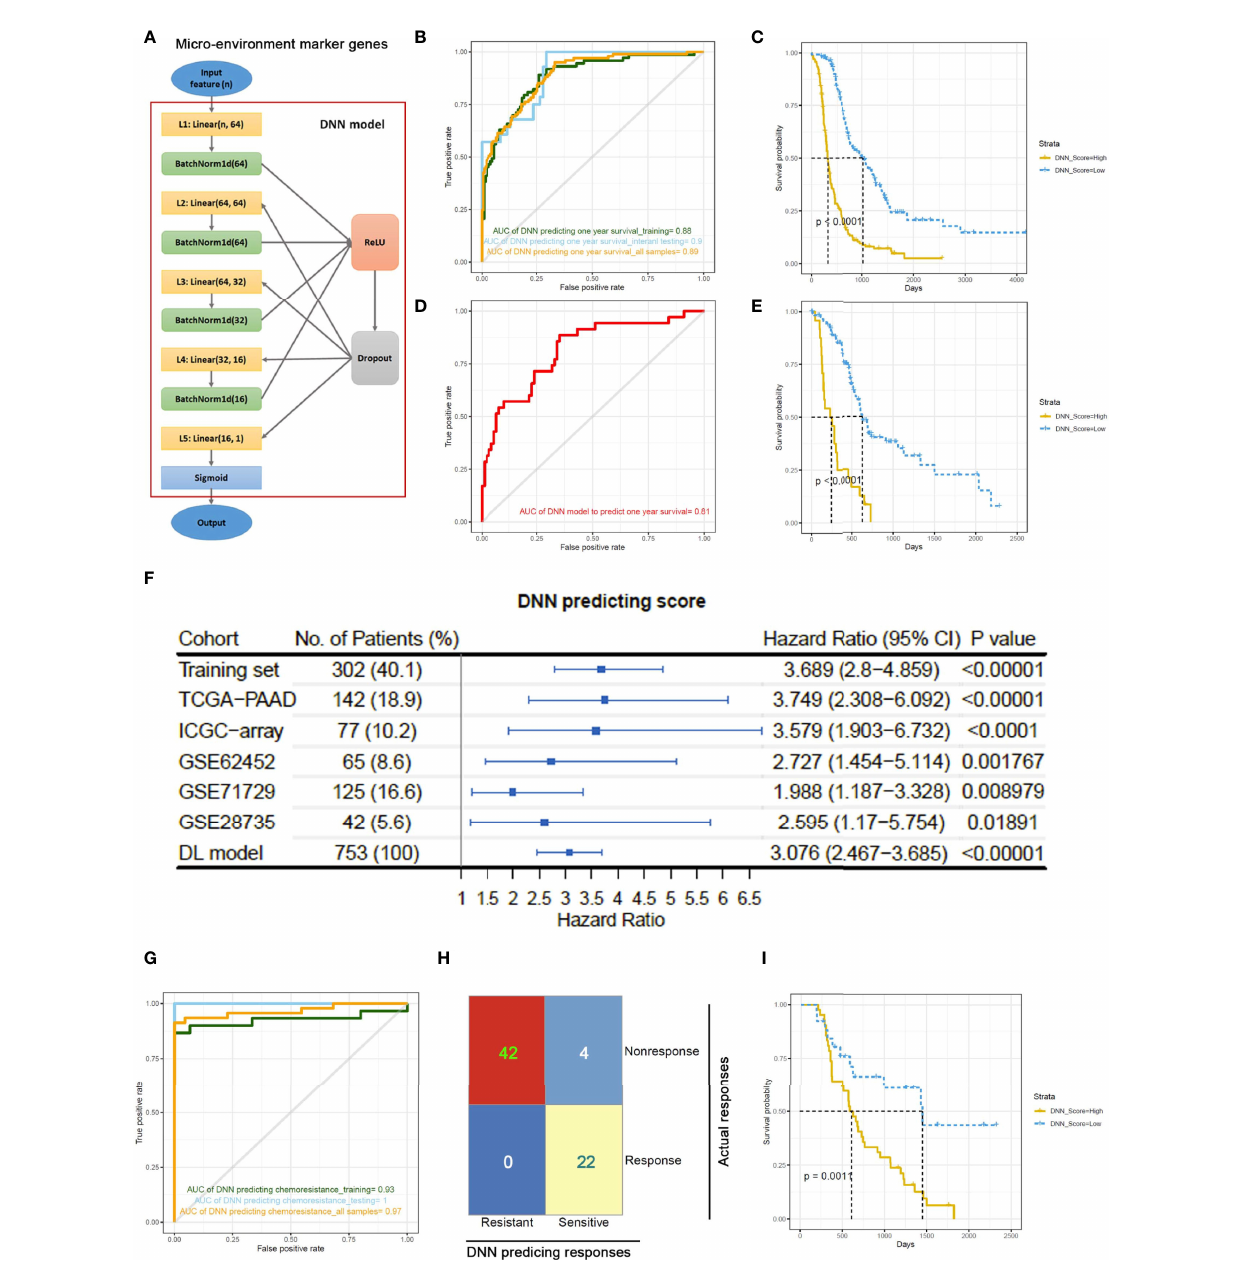
FIGURE 3 | A deep neural network (DNN) model predicts outcomes of PDAC patients based on the expression of MEMGs. (A) The framework of the deep neural network (DNN) containing fi ve layers. (B) The samples in a combined PDAC dataset were randomly divided into training groups (2/3) and internal testing groups (1/3). The DNN model was trained in training samples by 400 iterations and tested by internal testing samples and all samples. ROC curves show the 1-year survival predicting accuracies in each group. The area under the curve (AUC) values were shown. (C) The DNN probability score generated by DNN predictor in the all- sample-testing process was correlated with overall survival of patients. The Kaplan – Meier plot shows the survival rates, and statistical signi fi cance was tested by log- rank test. (D, E) The prognostic capability of DNN model was examined in the external testing set. The ROC curve (D) and Kaplan – Meier plot strati fi ed by DNN scores (E) were shown. (F) Systematical cox analyses estimate the HR of DNN scores in multiple PDAC datasets from TCGA, ICGC, or GEO databases. The meta- analysis was performed using DL (DerSimonian and Laird) model to estimate the general prognostic effect of DNN score in pancreatic cancer patients. (G) The DNN framework was also trained to be a chemotherapy response predictor using a cohort of PDAC patients undergone chemotherapy. ROC curves show the AUC values using a DNN model to predict chemotherapeutic responsiveness in training, testing or all samples. (H) A confusion matrix demonstrates the accuracy of DNN model in predicting chemo-response. (I) DNN score correlates with patient ’ s survival after chemotherapy. The survival rates were shown in Kaplan – Meier plot. The differentiation was tested by log-rank